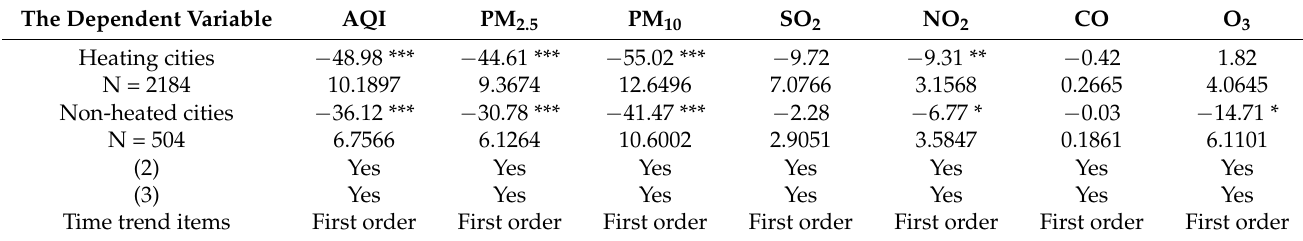
Table 6. Results of RD estimation of daily frequency in heated and non-heated cities.